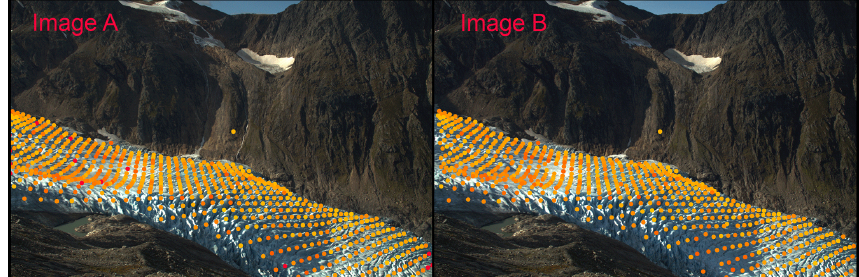
Figure 5. Screen shot of the templatematch stage of the processing chain. The regularly spaced grid can be seen in left hand image and the corresponding “tracked” points can be seen in the right hand image . The marker colour corresponds to the signal minus the noise, yellow indicating a good match between image pair